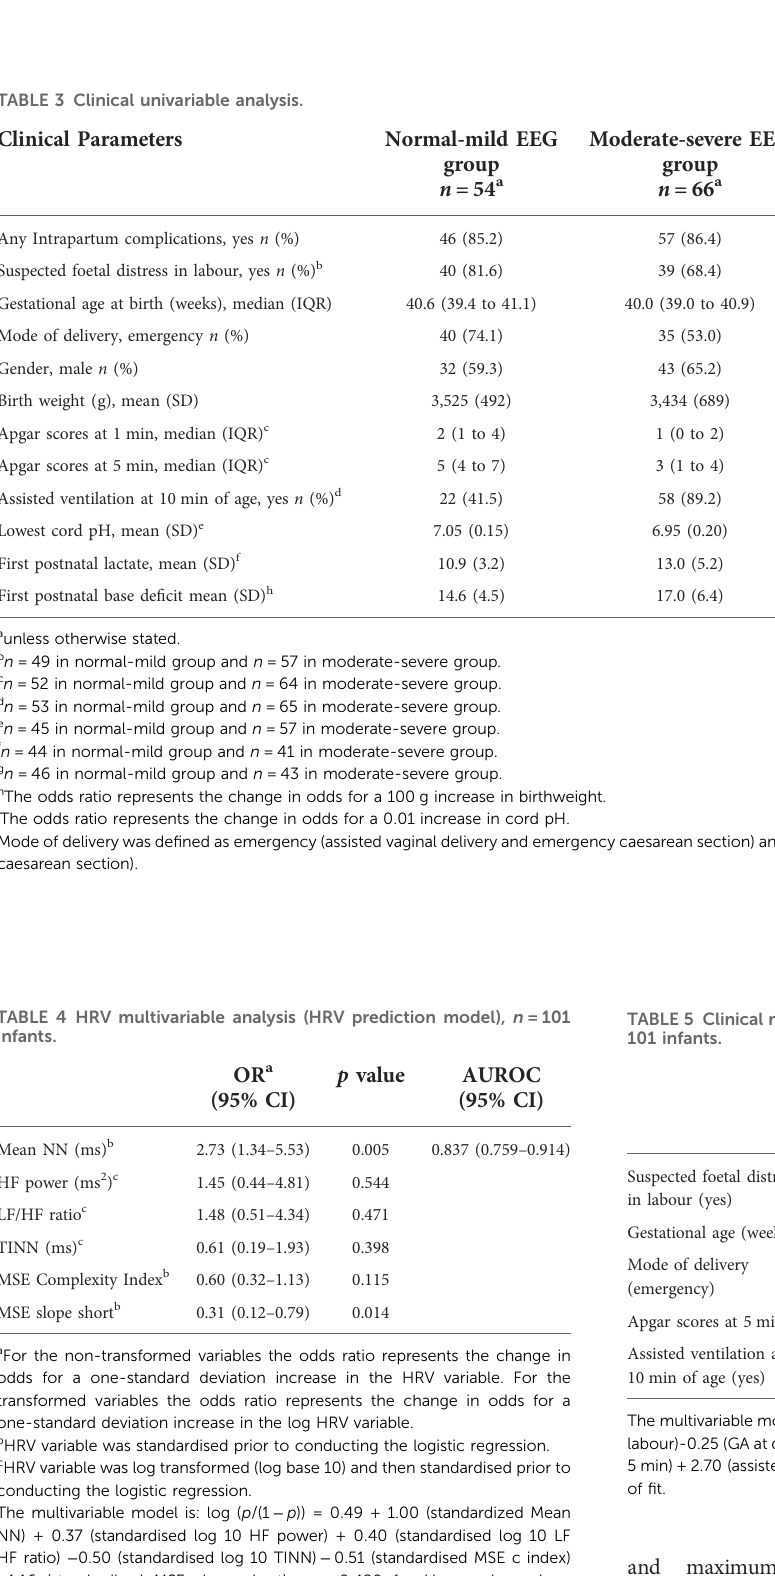
encephalopathic EEG grade. When these HRV features were combined into a prediction model, the performance improved beyond individual features. The clinical model had a similar predictive value to the HRV model. However, the model with